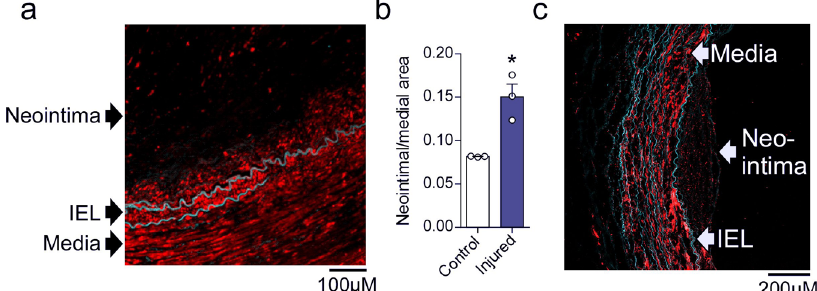
Fig. 5 sGC β 1 expression is reduced in the neointima of diseased and injured human arteries. a Immunostaining showing sGC β 1 protein expression (red color) in diseased arteries from PAD patients. IEL: Internal elastic lamina. b Neointima-to-media ratio in control and injured IMA segments; t test; n = 3 independent experiments. c Immunostaining showing sGC β 1 protein expression in an injured IMA segment. IEL: Internal elastic lamina. Cyan color is auto fl uorescence from the elastic lamina. Bars indicate means ± SEM. Representative images from 3 biological replicates. * p <